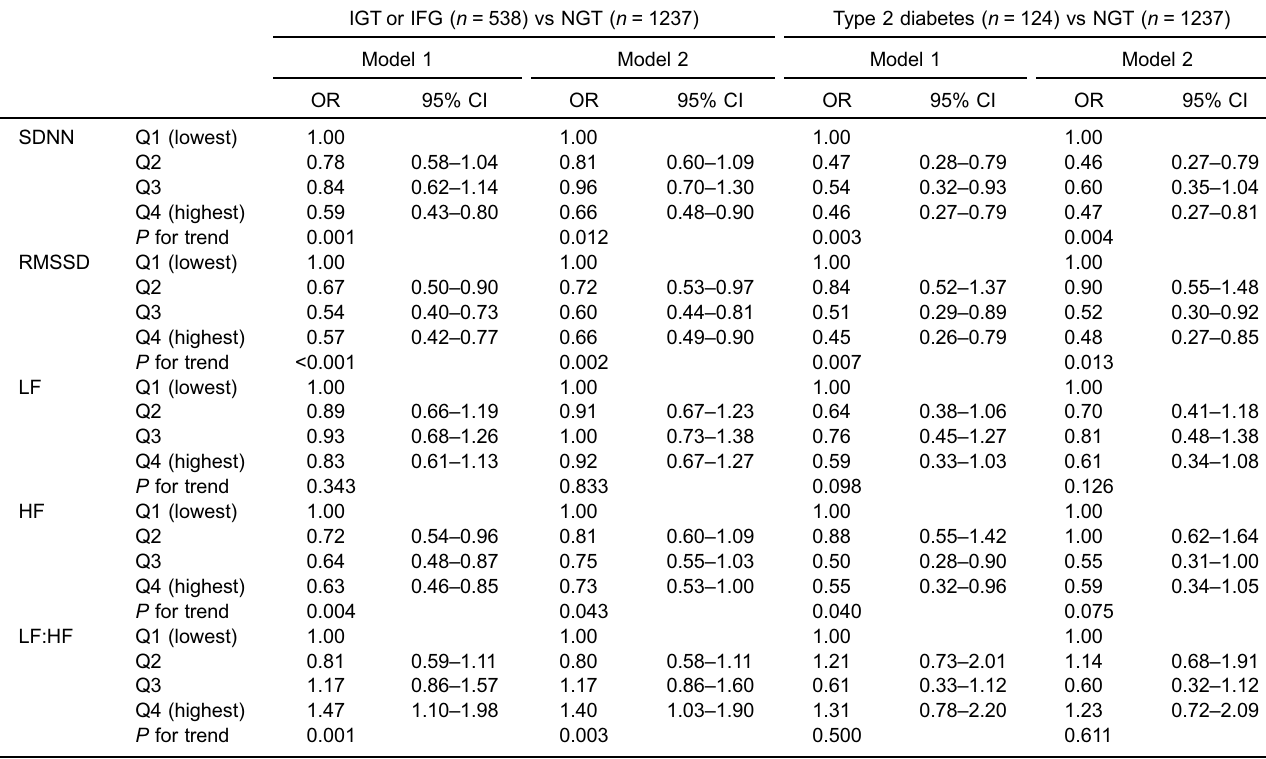
Table 4. Multivariable-adjusted odds ratios for IGT, IFG, or type 2 diabetes compared with NGT, grouped according to quartiles of the heart rate variability